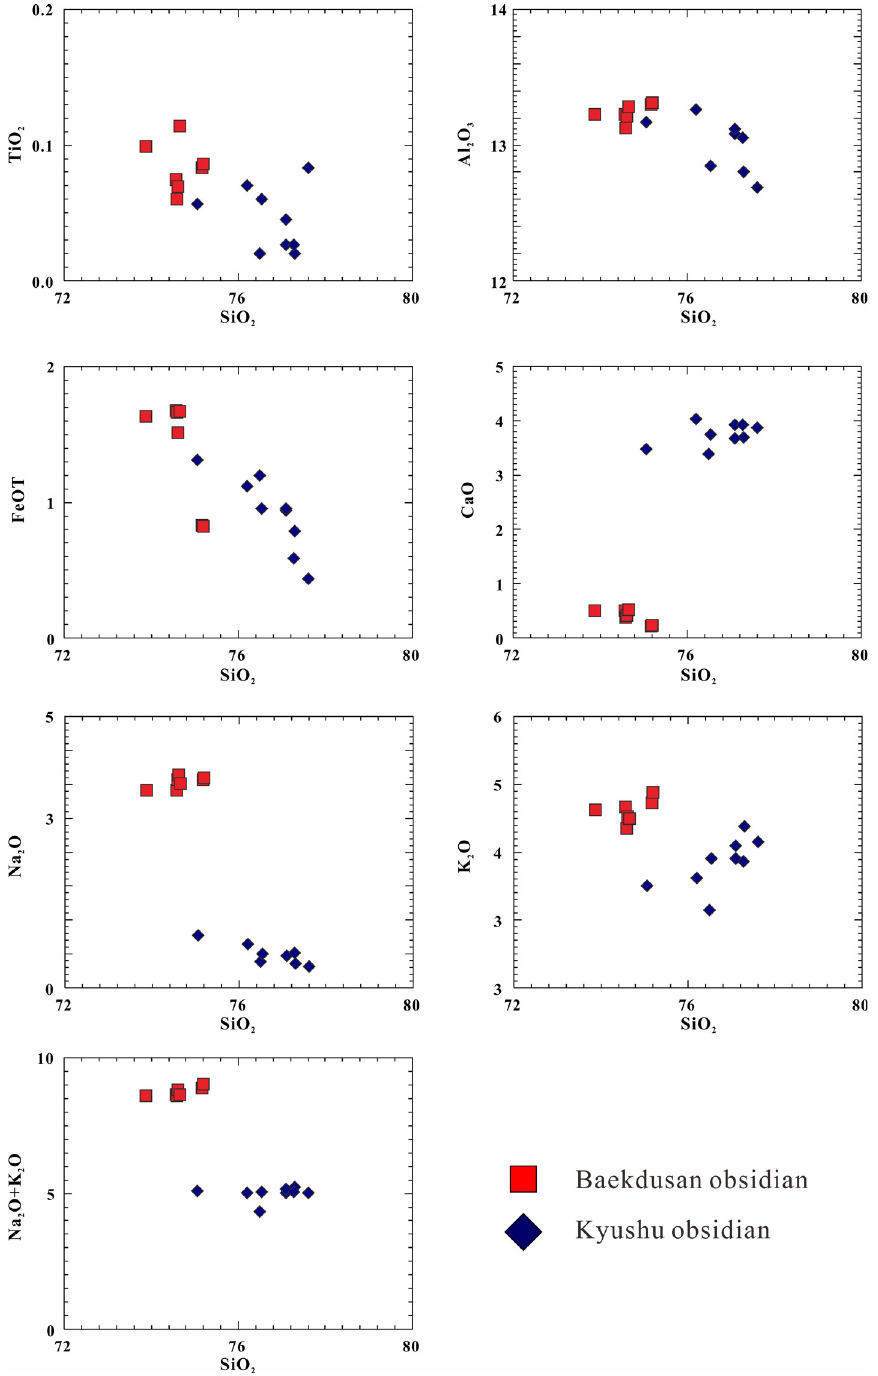
versus major oxide contents (wt. %) variation diagrams for the Baekdusan and Kyushu Figure 7. SiO 2